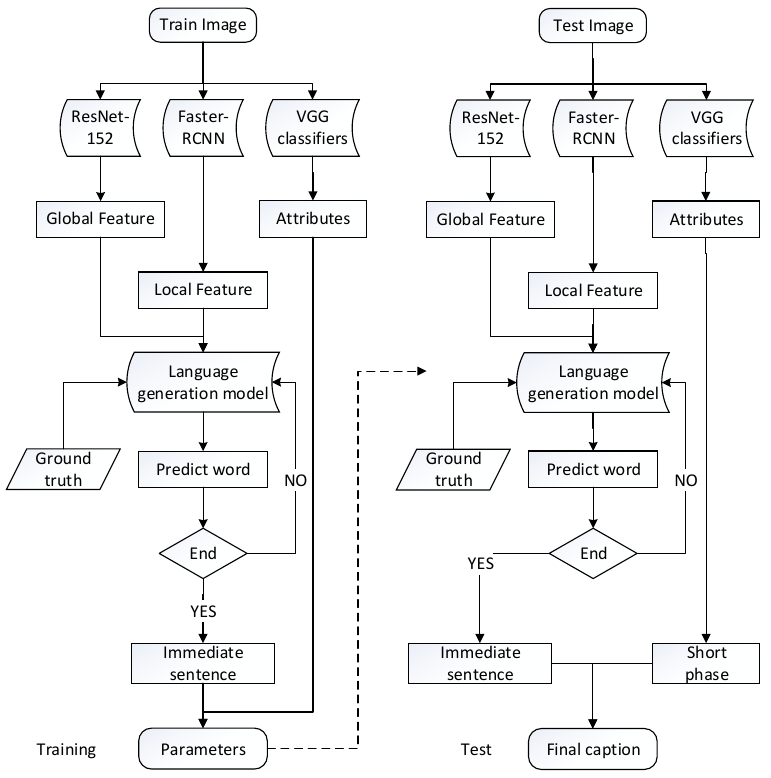
Figure 3. Experiment sketch. The experiments are separated into two parts, including the training phase and test